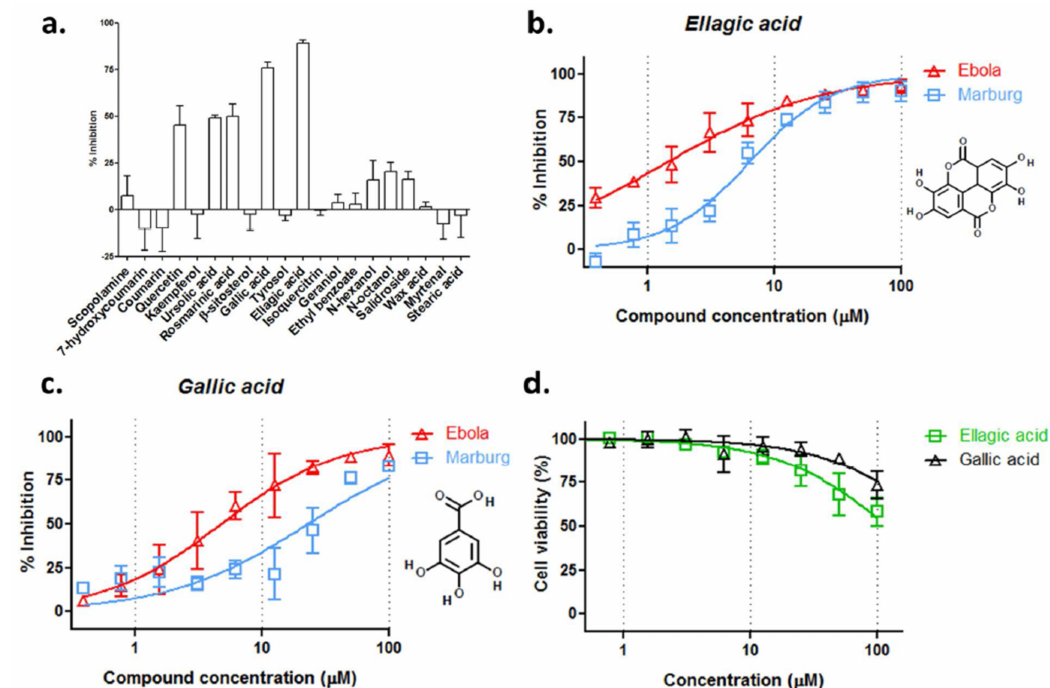
Figure 3. Identification of ellagic acid and gallic acid as the most active components of R. rosea against EBOV infection. ( a ) Twenty known R. rosea components were tested against pseudotyped EBOV infection at 12.5 µ M; ( b ) Ellagic acid and ( c ) gallic acid were examined against HIV/EBOV ( ∆ , red) and HIV/MARV ( (cid:3) , blue) infection in A549 cells in vitro for dose-response evaluation; ( d ) Cell viability assay of ellagic acid and gallic acid in A549 cells. Data are means ± SD ( n = 3) from three independent experiments. The IC 50 /CC 50 Values, 95% confidence intervals and selectivity indices for ellagic acid and gallic acid are listed in Supplementary Materials Table